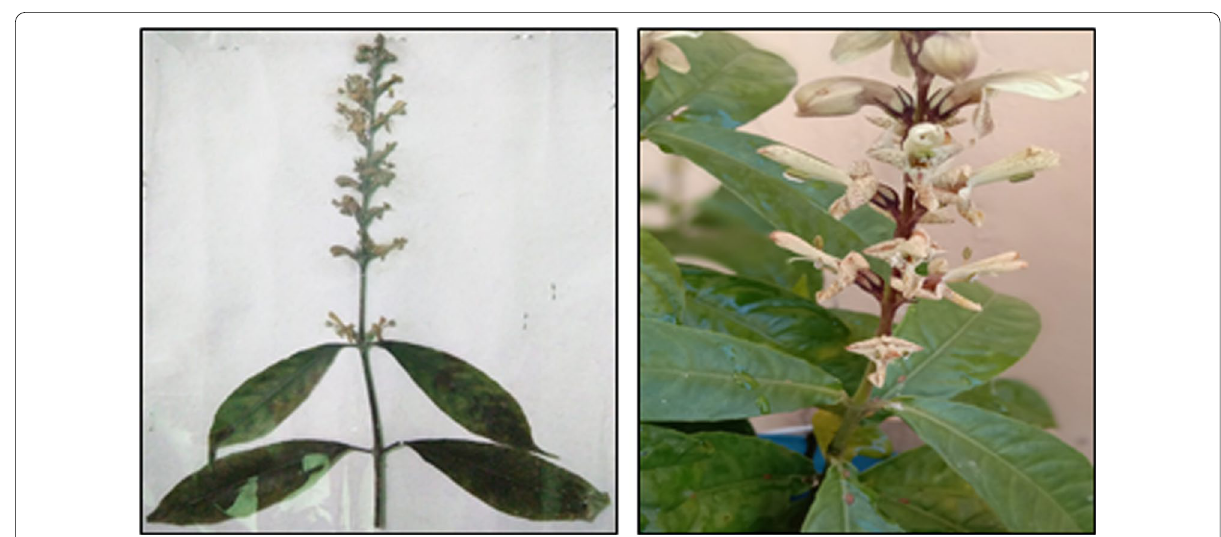
Fig. 10 E. indicum (Nees) (leaf and